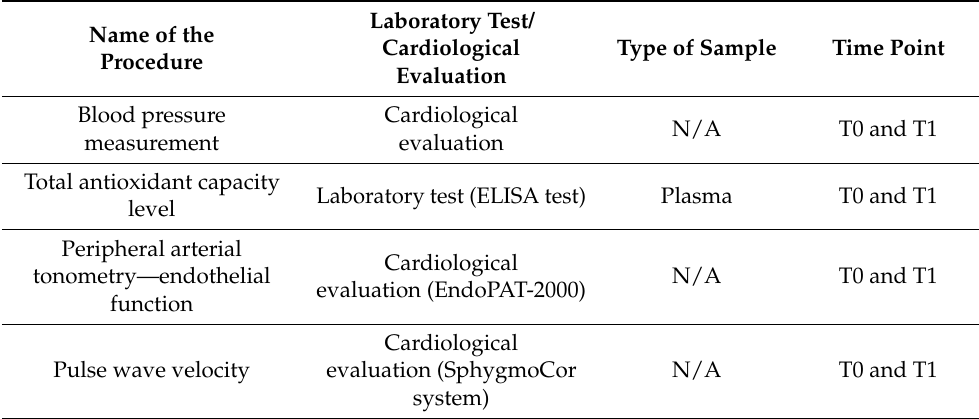
Table 7. Schematic summarizing of the biomarkers that were considered and of the cardiological evaluations that were carried